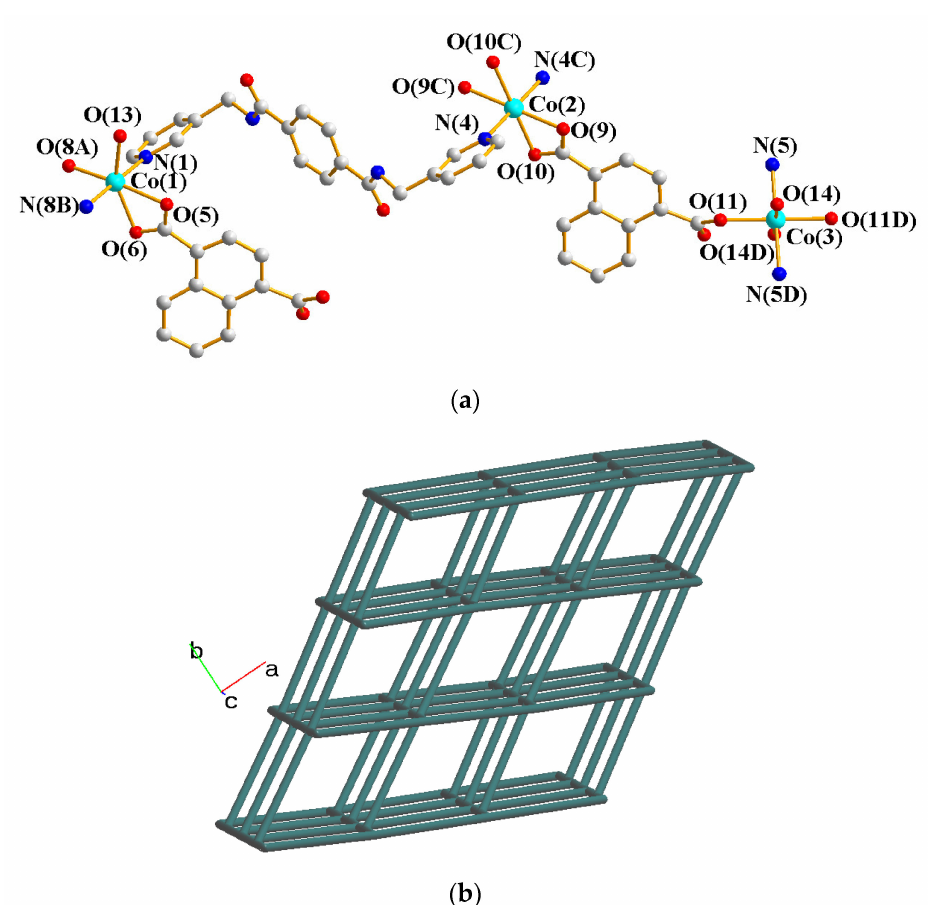
Figure 7. ( a ) The coordination environment of the Co(II) ion in 6 . Symmetry transformations used to generate equivalent atoms: (A) x, − y + 3/2, z + 1/2; (B) –x + 1, y − 1/2, − z − 1/2; (C) –x + 2, -y + 2, − z − 1; (D) –x + 2, − y + 2, − z − 2. ( b ) A drawing showing the cds